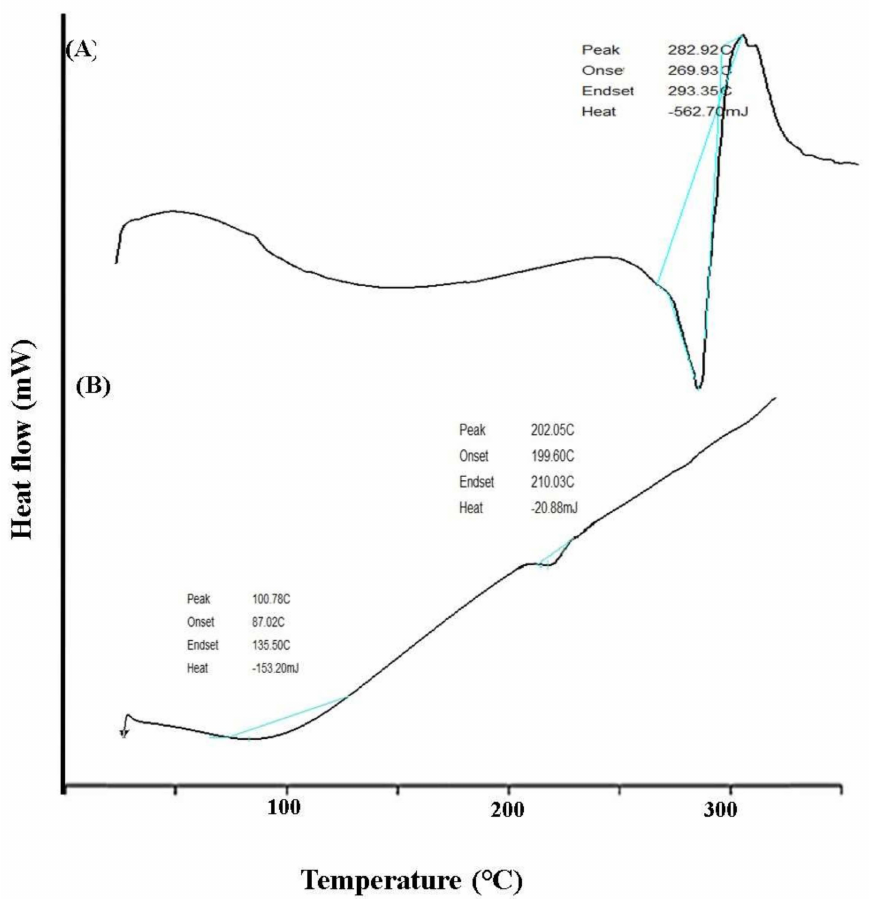
Figure 7. DSC thermograms of ( A ) pure gemcitabine and ( B ) mixture of gemcitabine and sodium carboxymethyl cellulose.